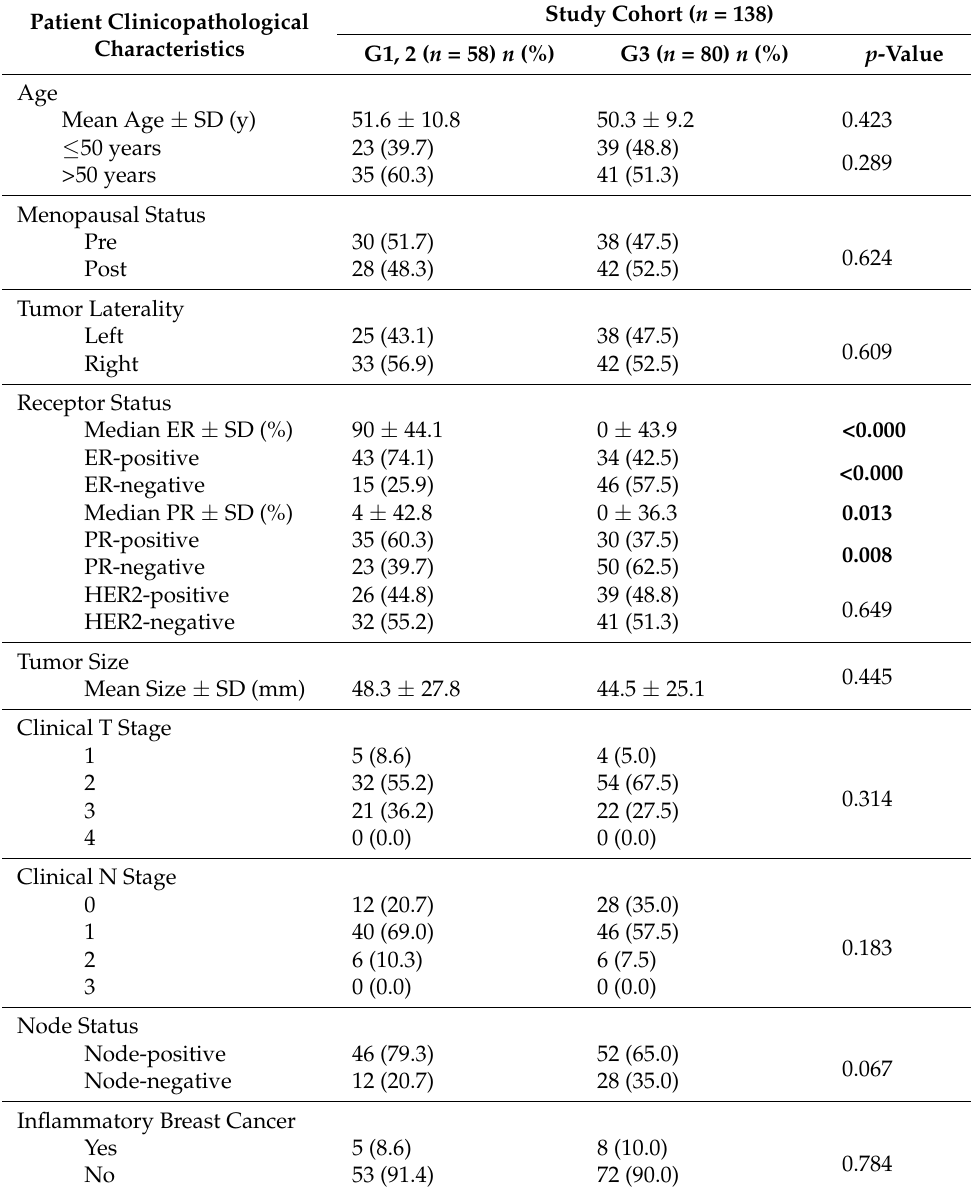
Table 1. Clinicopathological characteristics of the patients with G1, 2 and G3 breast cancer tumors. Bolded values represent statistical significance ( p < 0.05). Abbreviations: G1, 2, Nottingham grade 1 and 2; G3, Nottingham grade 3; SD, standard deviation; y, years; ER, estrogen receptor; PR, progesterone receptor; HER2, human epidermal growth factor. Patient Clinicopathological